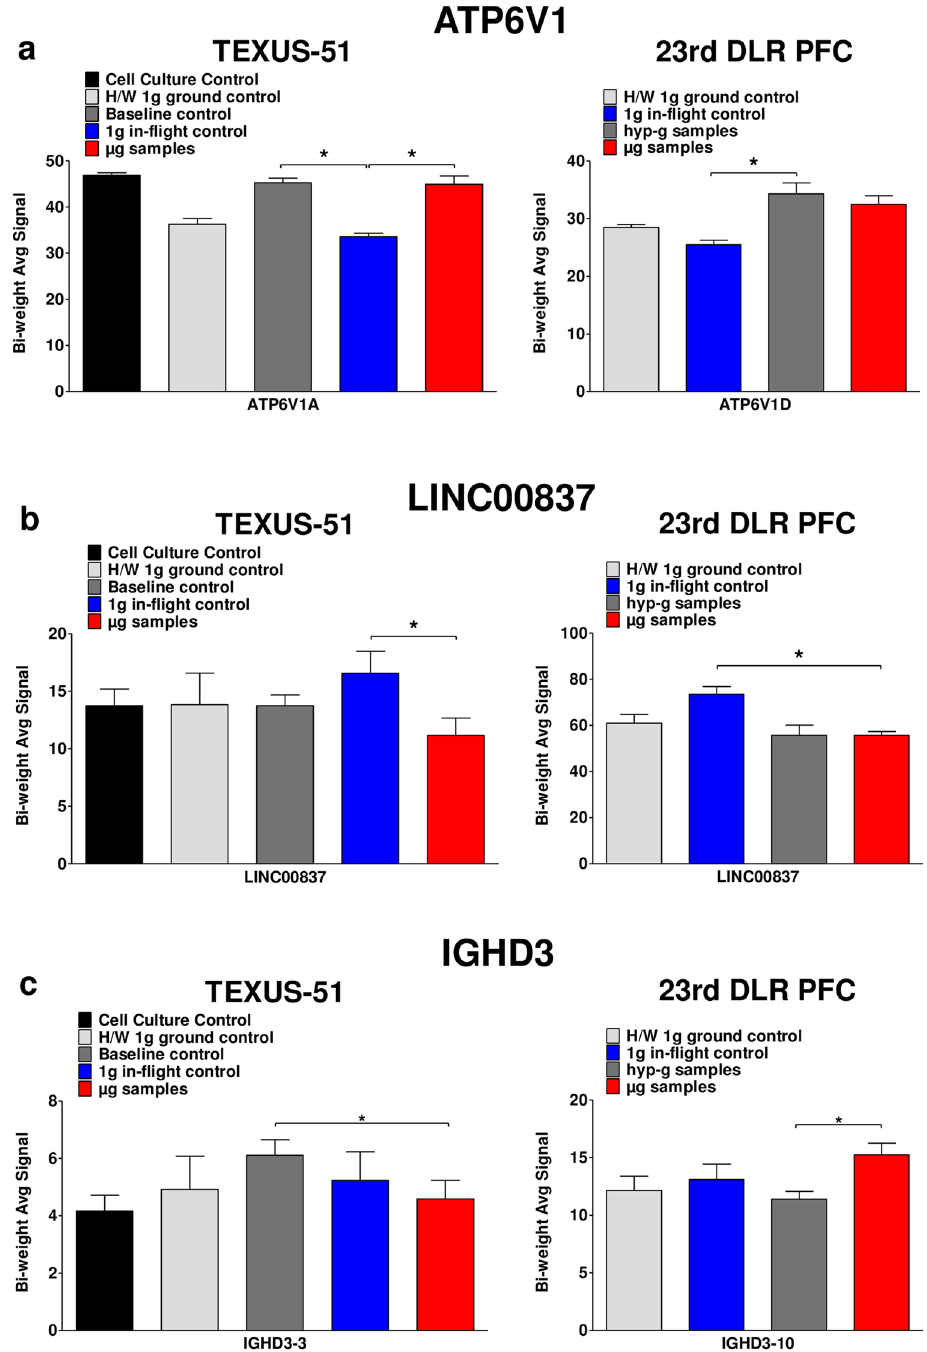
Figure 11. Gravity-regulated genes in human Jurkat T cells. Three genes were identified being differentially expressed under altered gravity conditions during parabolic flight and suborbital rocket flight. Tukey’s Biweight Function of linear values are demonstrated. ( a ) ATP6V1 encodes for a component of the H + vacuolar-type ATPase. After 20 s hypergravity, the D subunit of this enzyme is up-regulated compared to the 1 g in-flight control. After 75 s of hypergravity as well as after 5 min of microgravity, the A subunit of this protein is still significantly up-regulated. ( b ) LINC00837 is a Long Intergenic Non-Protein Coding RNA. This regulatory RNA is down-regulated after 20 s and 5 min of microgravity compared to 1 g in-flight. ( c ) IGHD3-3 and IGHD3- 10 belong to the cluster of functional diversity (D) genes in the immunoglobulin (Ig) heavy chain locus on chromosome 14. IGHD3-10 is up-regulated in microgravity versus hypergravity during a parabolic flight, while during a sounding rocket flight, IGHD3-3 is down-regulated after 5 min of microgravity compared to the baseline control representing the hypergravity